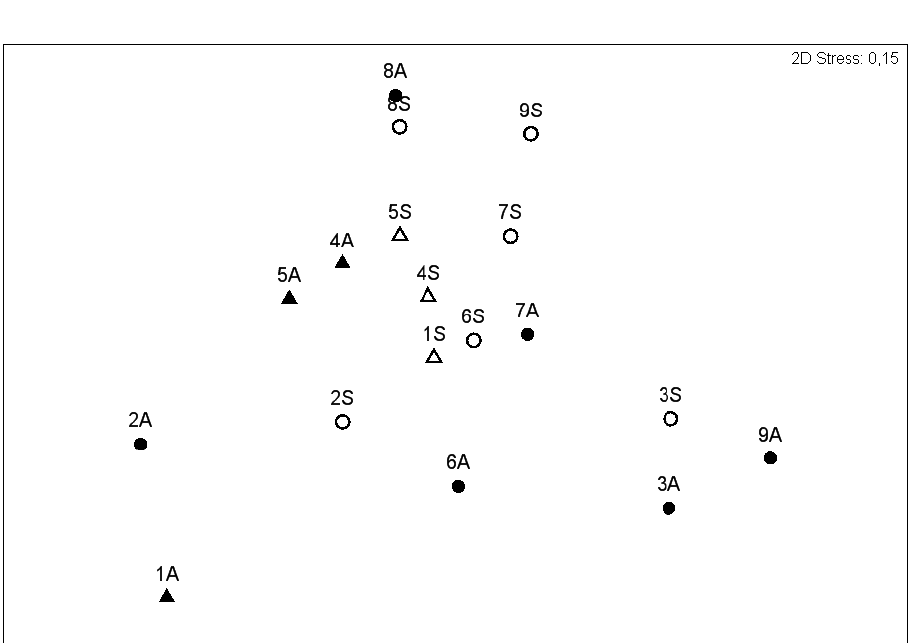
Figure 4. Multidimensional scaling (n-MDS) of sectors in entrance areas in April (A-black triangles), and sectors in deep areas of the cave in April (A-black circles), and sectors in entrance areas in September (S-white triangles), and sectors in deep areas of the cave in September (S-white circles), by the Bray-Curtis quantitative similarity